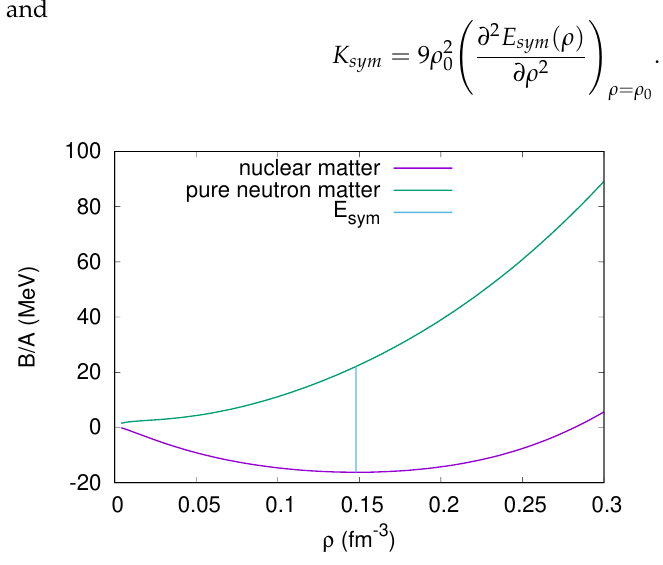
Figure 7. Schematic representation of the nuclear matter symmetry energy. Experimental data for the symmetry energy can be inferred from heavy-ion collisions, giant monopole (GMR) and giant dipole (GDR) resonances, pygmy dipole resonances and isobaric analog states. Accepted values for the slope until very recently lay in between 30.6 and 86.8 MeV [37,38] and for the curvature, in between − 400 and 100 MeV [39,40].